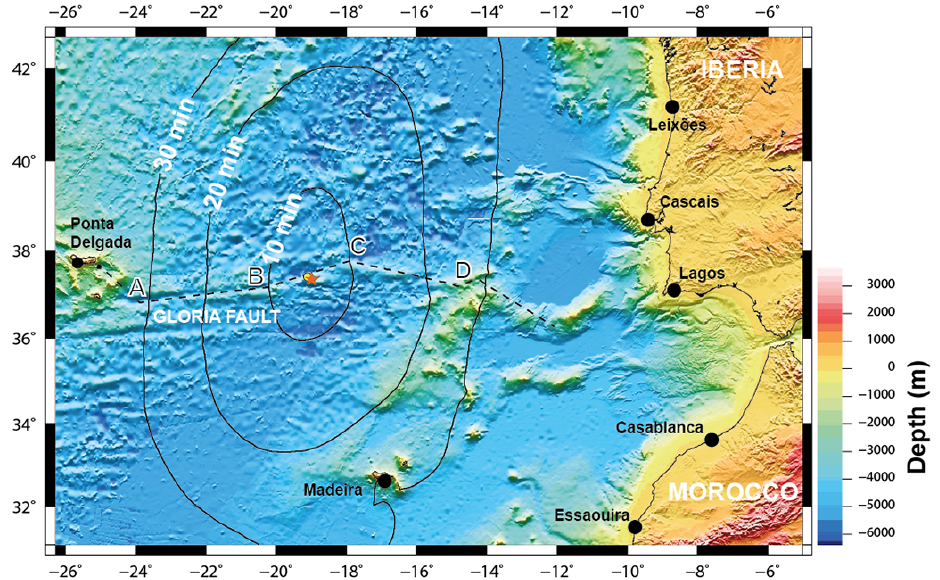
Figure 4. Tsunami source location given by BRT. The red star represents the minimum of the backward ray tracing misfit ( ∼ 7min) at − 19 ◦ E, 37.35 ◦ N, less than 10km away, to the SE of the seismic epicentre − 19.038 ◦ E, 37.405 ◦ N (yellow circle). Black dots represent the tide stations. Segments AB and CD follow the small circle of the Eurasia–Nubia rotation pole; the angle between segment AB and BC is 12 ◦ with the small circle of Nuvel